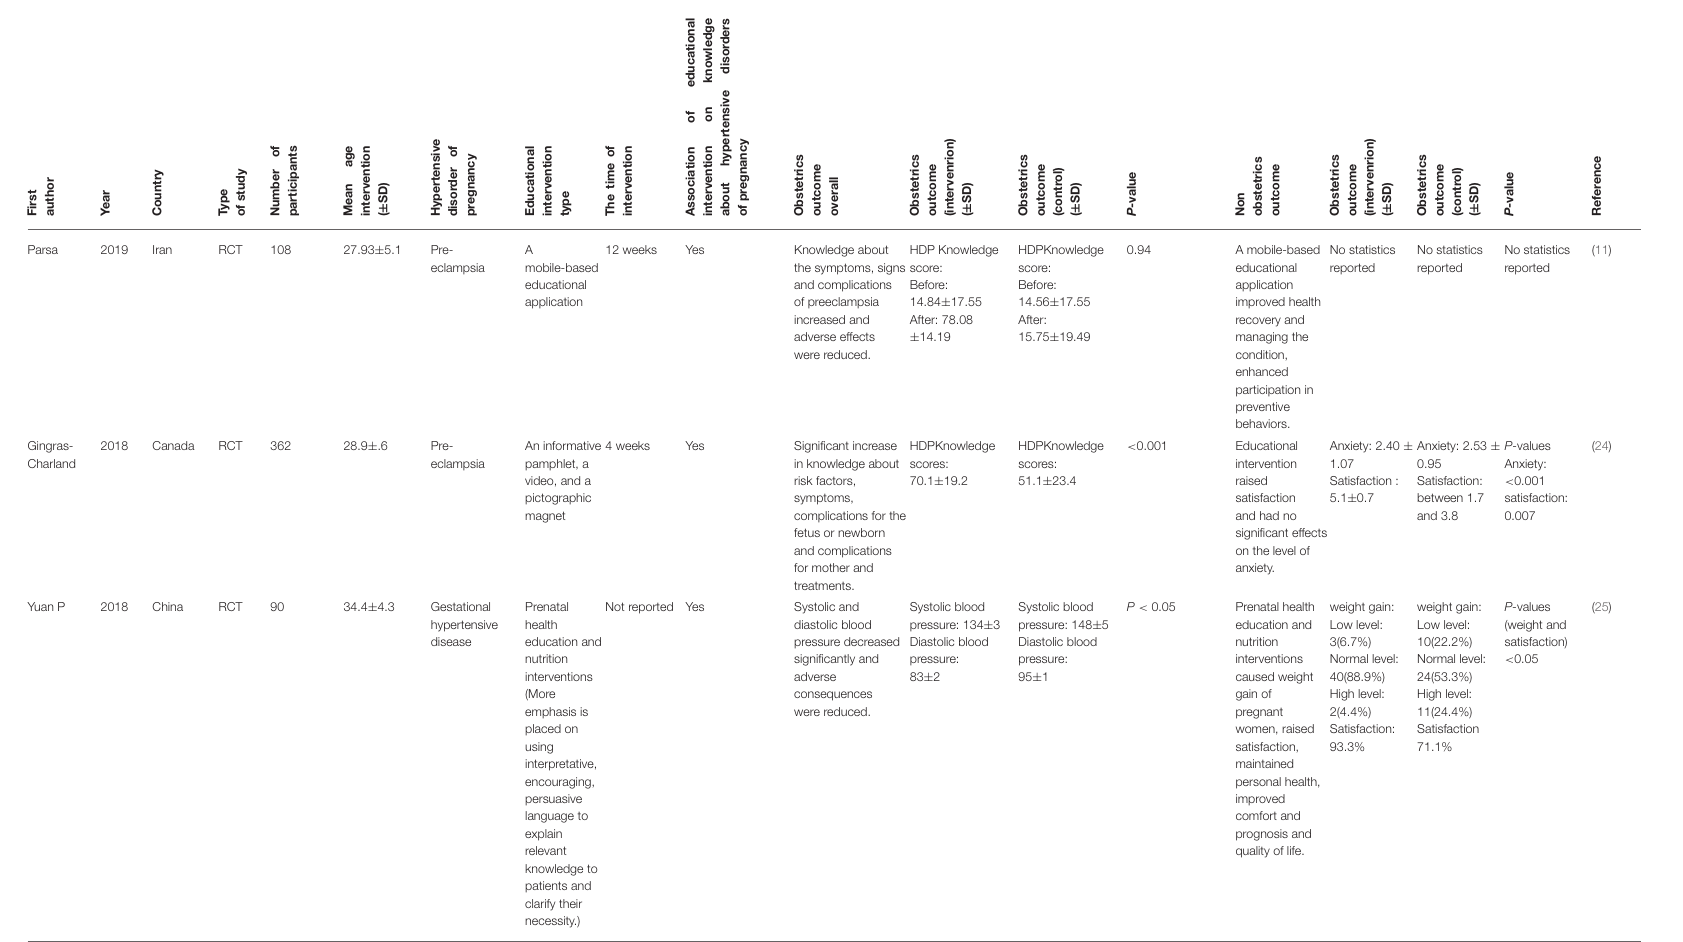
TABLE 2 | A summary of the findings of the included